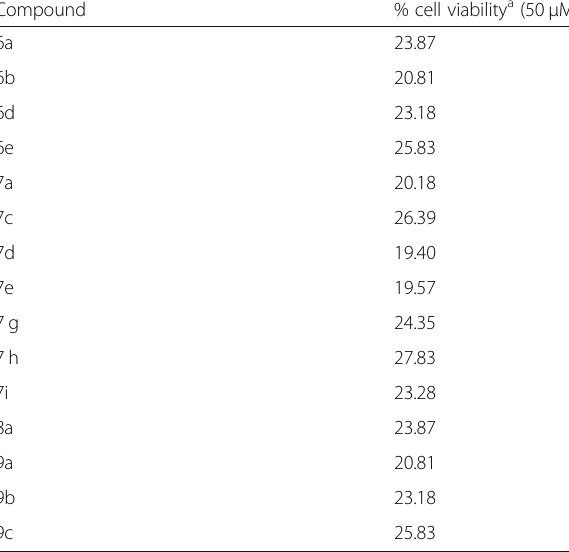
Table 3 Cytotoxicity of compounds against HDF